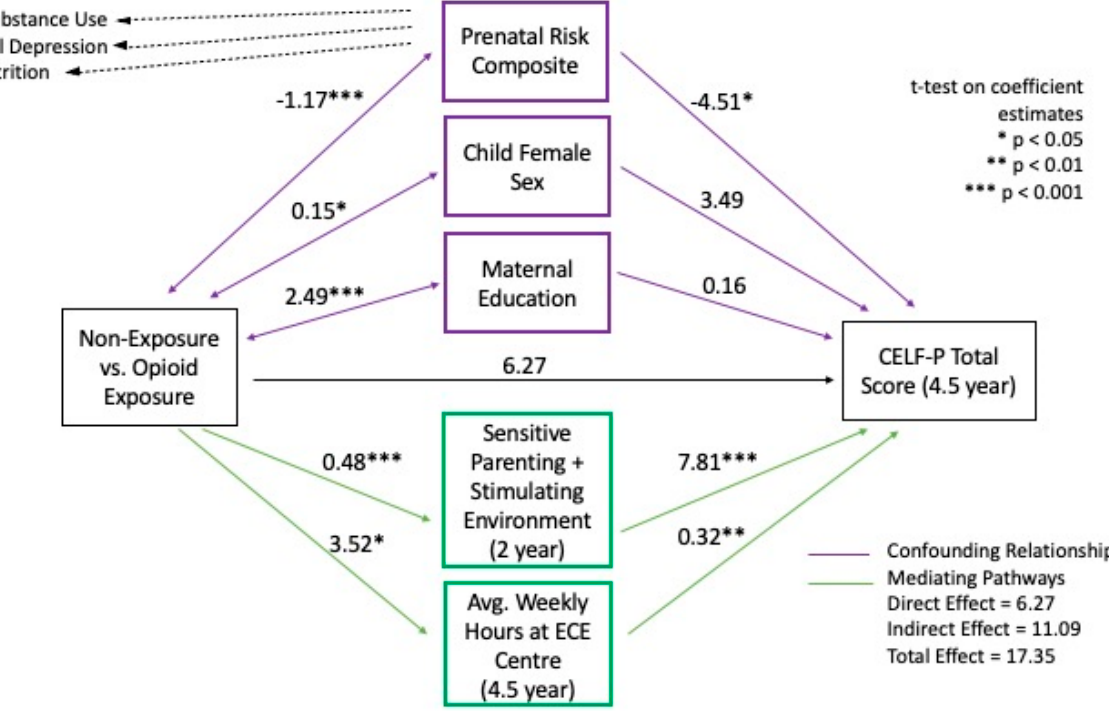
Figure 3. Mediation model.